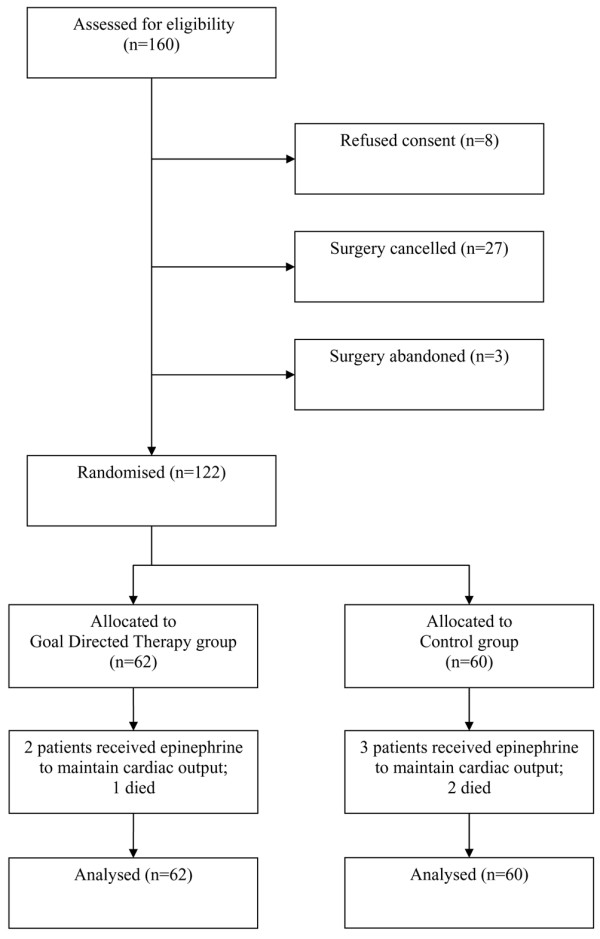
Flow of participants through the trial.